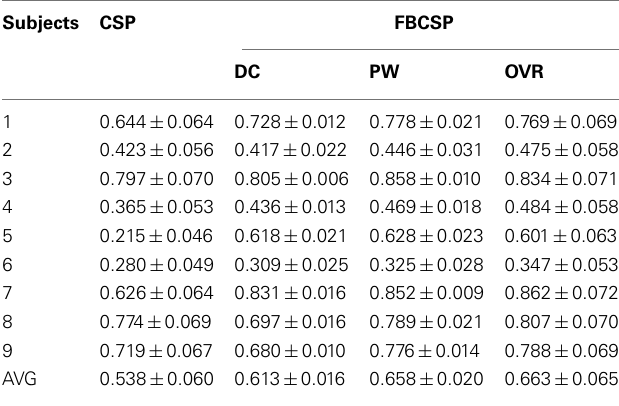
Table 1 | 10 × 10-fold cross-validation performance in terms of maximum kappa value using CSP and the 3 approaches of multi-class extensions to FBCSP on the training data from BCI Competition IV Dataset